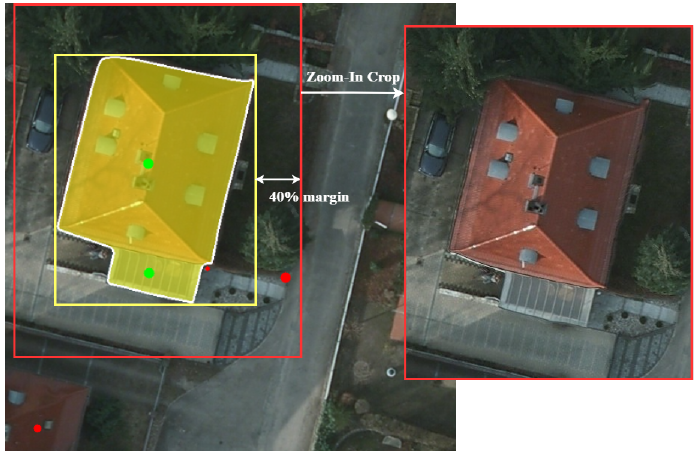
Figure 3. Example of the Zoom-In technique applied to remote sensing images. The green and red points stand for positive and negative clicks, respectively. The yellow bounding box is determined by the extreme points of the previous mask.